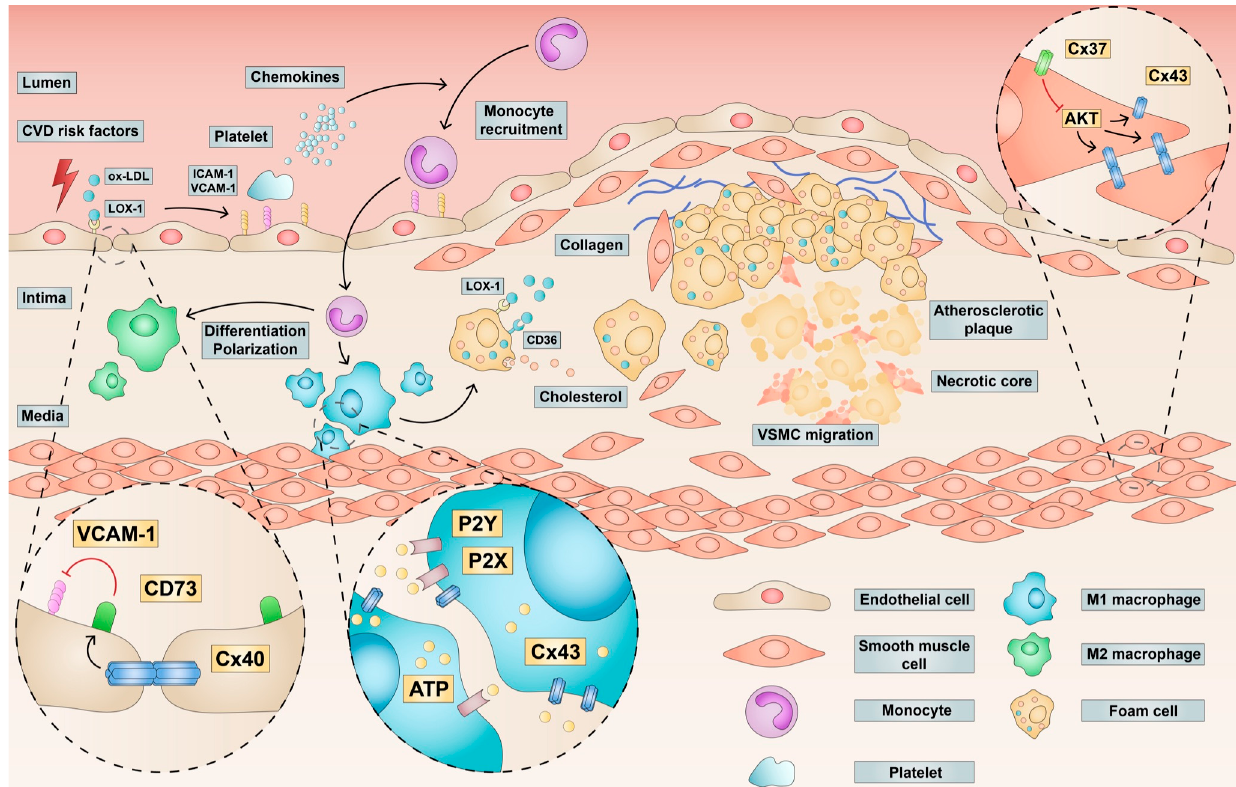
Figure 5. Development of an atherosclerotic plaque and hypothetical roles of Cx in this process. Cx40 stimulates expression of CD73 which has antiadhesive properties. ATP release through Cx43 contributes to macrophage activation and M1 polarisation. Cx37 suppresses AKT protein and disrupts the Cx43. ATP—adenosine triphosphate; Cx—connexin; ICAM-1—intercellular adhesion molecule 1; LOX-1—lectin-like oxidized low-density lipoprotein receptor 1; ox-LDL—oxidised LDL; P2X/P2Y—purinergic receptors; VCAM-1—vascular cell adhesion molecule 1; VSMC—vascular smooth muscle